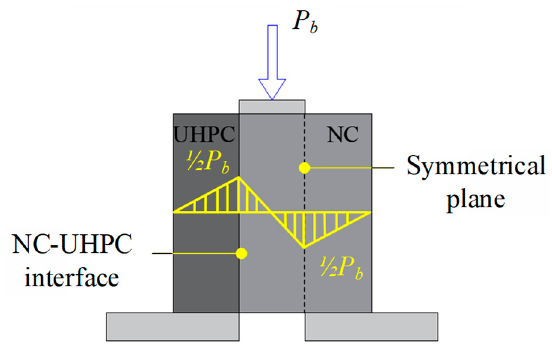
Figure 8. Internal shear force in the bi-shear specimen.